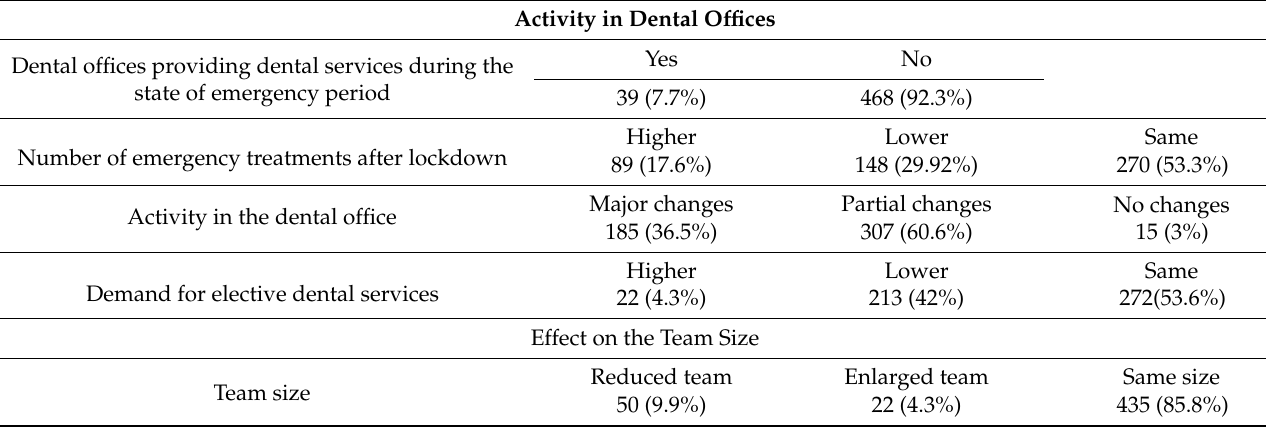
Figure 1. Financial effects generated by the COVID-19 pandemic in dental offices. Table 1. Economic changes generated by the COVID-19 pandemic in dental